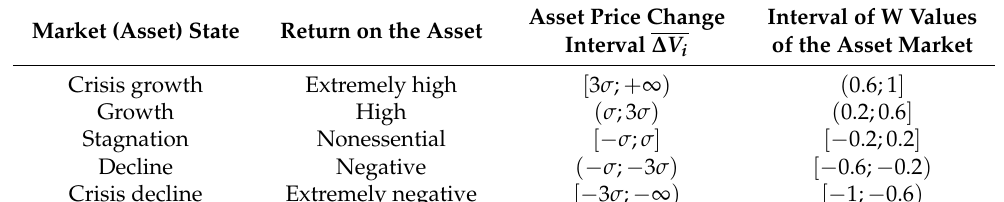
Table 4. Scale of return boundaries.